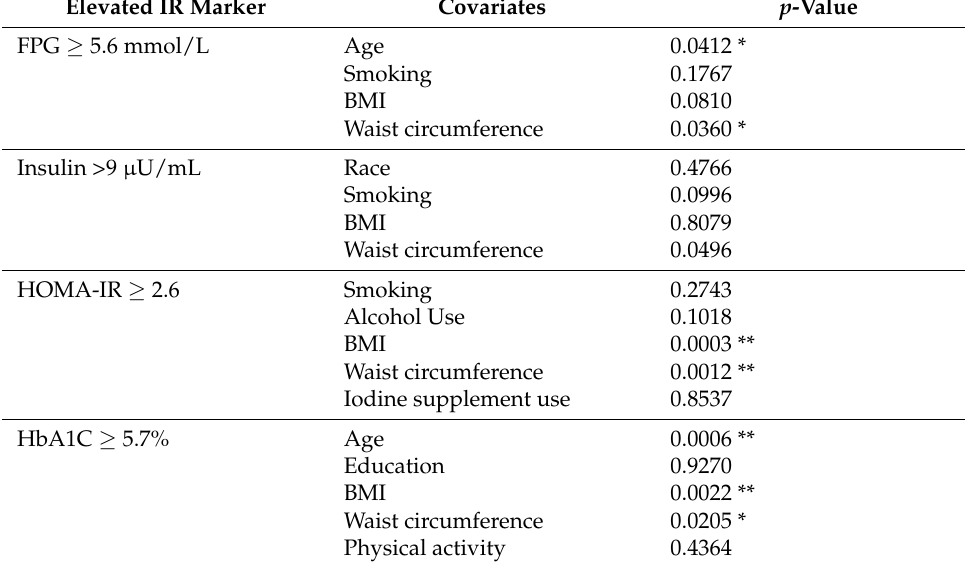
Table 5. Covariates used in adjusted model (model 2) for elevated markers of insulin resistance in relation to urinary iodine concentration of US female adults, NHANES 2011–2012 1